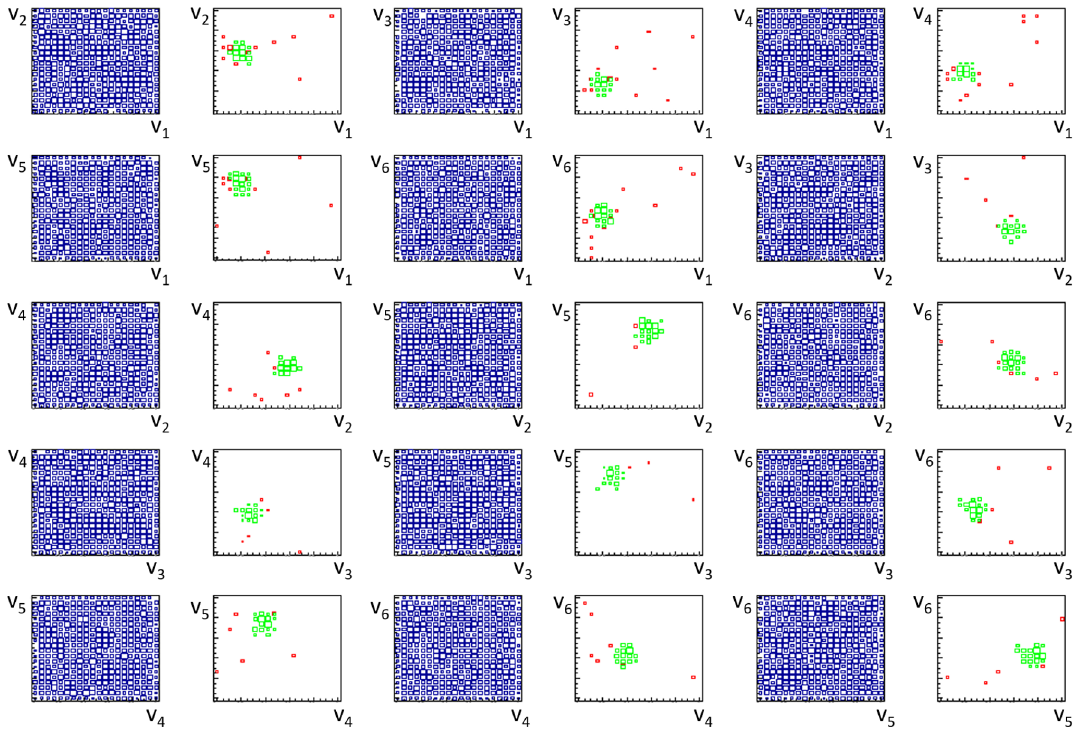
Figure 10 . Copula space scatterplots of the six features defining the subspace, among 1000 randomly chosen ones, where RanBox finds the highest- Z box in a run on 5000 synthetic events, 4950 of them PL generated from a D = 20 -dimensional uniform distribution and the remaining 50 “signal” events generated with 11 features drawn from a multidimensional Gaussian distribution. The distribution of the totality of the data is shown in blue on the left of each pair of graphs, while the distribution of selected events (in green) is shown in green on the corresponding right graph; in red are events that fail to be included in the highest- Z box only because of their value of the shown features. From PL top to bottom and left to right each pair of graph describes the spaces ( v ) , ( v ) , ( v ) (first 1 , v 2 1 , v 3 1 , v 4 row), ( v ) , ( v ) , ( v ) (second row), ( v ) , ( v ) , ( v ) (third row), ( v ) , ( v ) , 1 , v 5 1 , v 6 2 , v 3 2 , v 4 2 , v 5 2 , v 6 3 , v 4 3 , v 5 ( v ) (fourth row), and ( v ) , ( v ) , ( v ) (fifth row). See the text for more 3 , v 6 4 , v 5 4 , v 6 5 , v 6